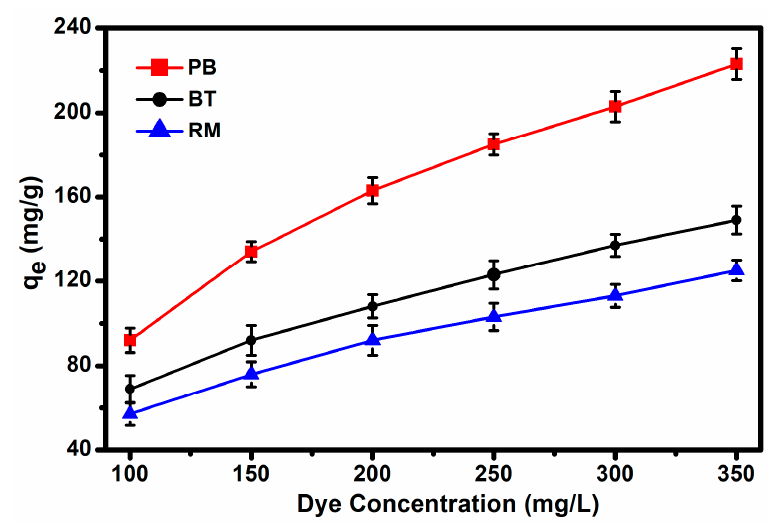
Figure 11. Effect of initial dye concentration on MG adsorption.